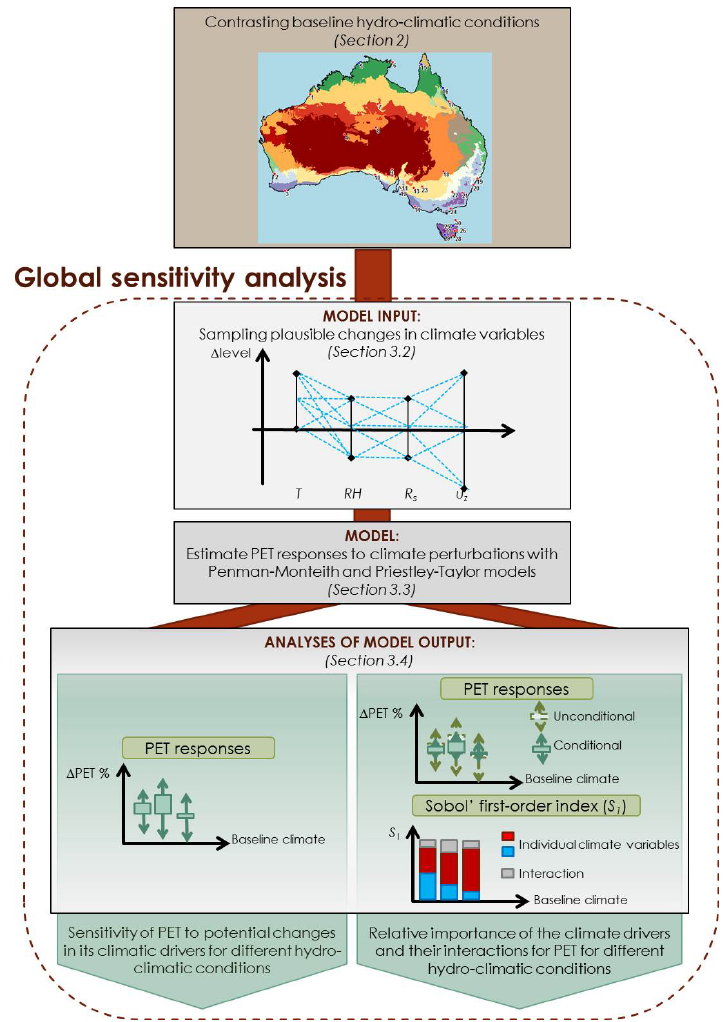
Figure 2. Schematic of the method used in this